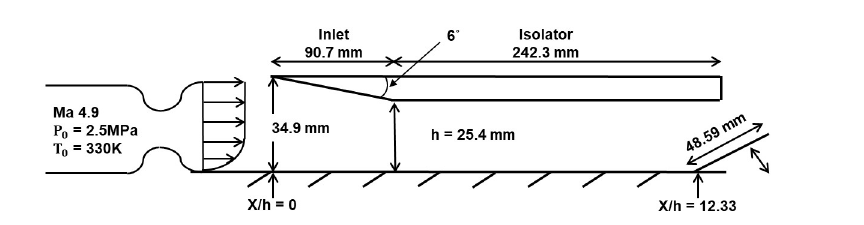
Fig 1. Schematic of the scramjet inlet isolator.